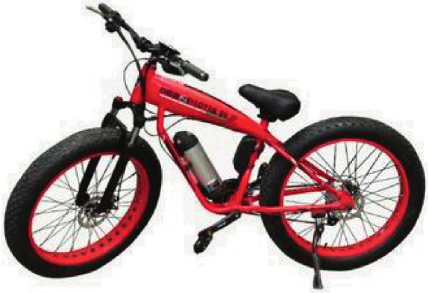
Figure 2: Prototype model of the DMW Electra 20 E-cycle